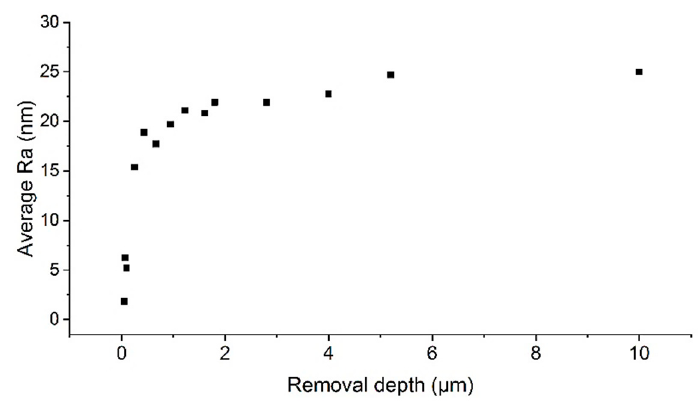
Figure 6. Roughness versus removal depth of APPP.